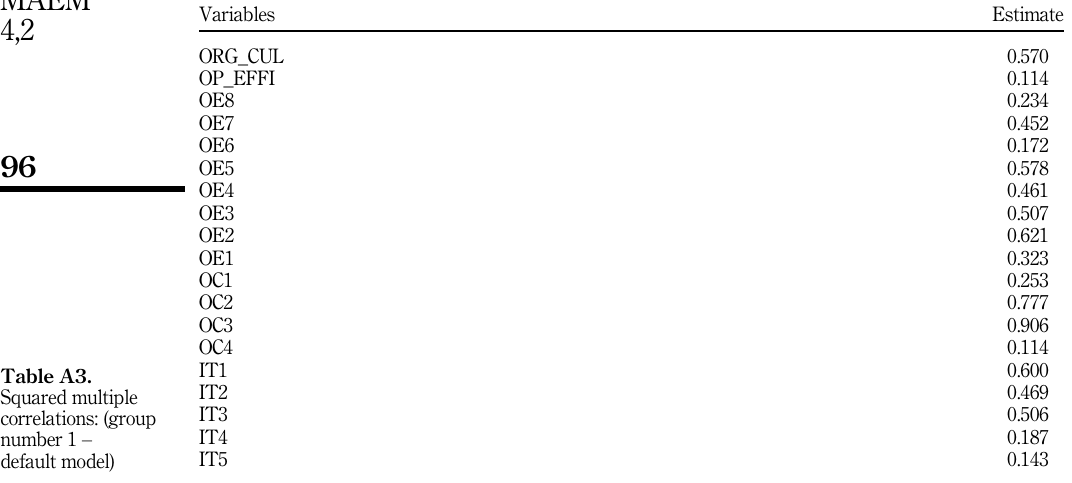
Table A3. Squared multiple correlations: (group number 1 – default